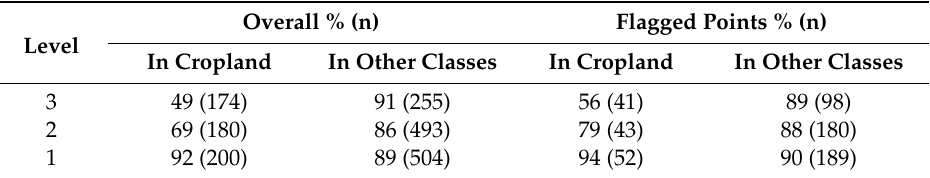
Table 2. LC percent agreement at di ff erent levels for all points and points flagged as potential high-quality, contrasting the Cropland class and non-cropland